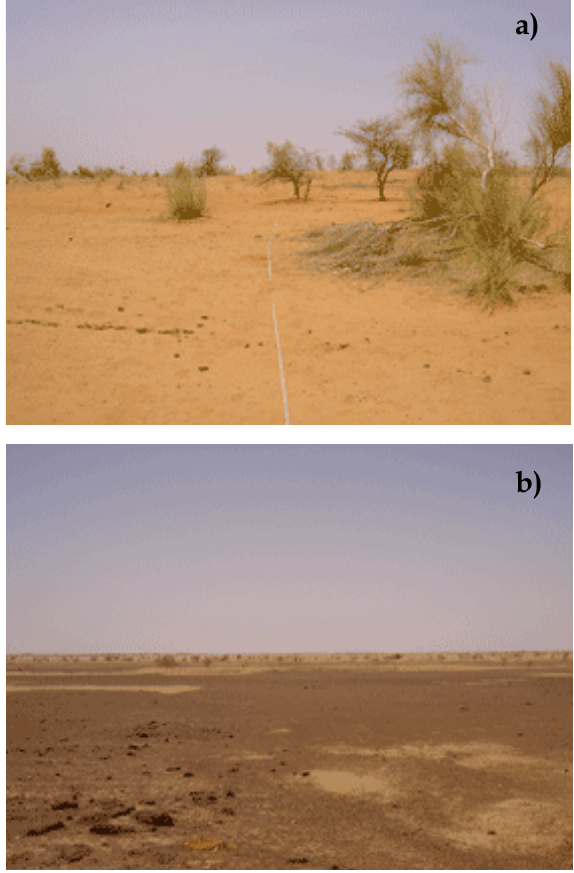
Fig. 1. Views of the Agoufou (a) , Eguerit (b) sites during the dry Fig. 1: Views of the Agoufou (a), Eguerit (b) sites during the dry season in April. season in April.